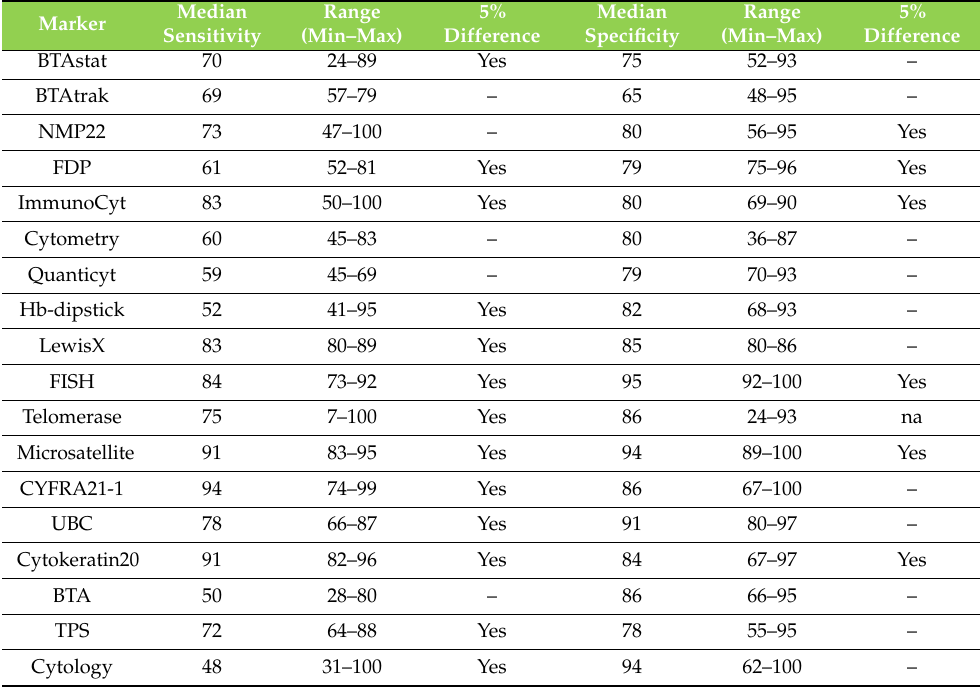
Table 2. Sensitivity and specificity of the data for various urinary biomarkers for surveillance of recurrent bladder cancer. Adapted from van Rhijn et al. [94].